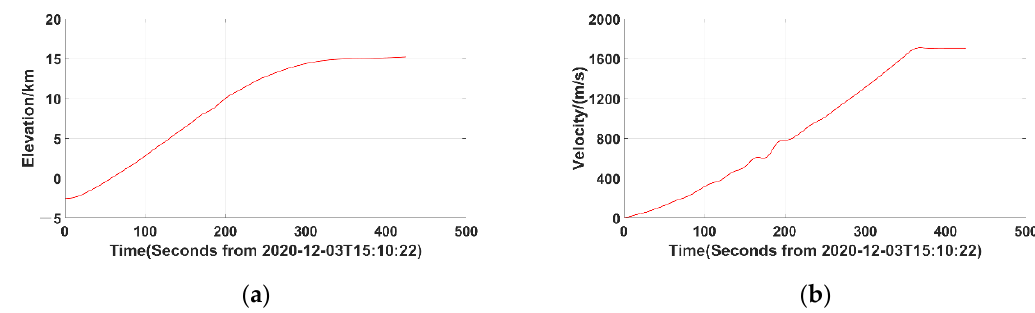
Figure 7. Elevation – time and velocity – time plots in CE-5 ’ s ascent trajectory: ( a ) shows elevation – time plot; ( b ) shows ve- Figure 7. Elevation–time and velocity–time plots in CE-5’s ascent trajectory: ( a ) shows elevation–time plot; ( b ) shows locity – time plot. velocity–time